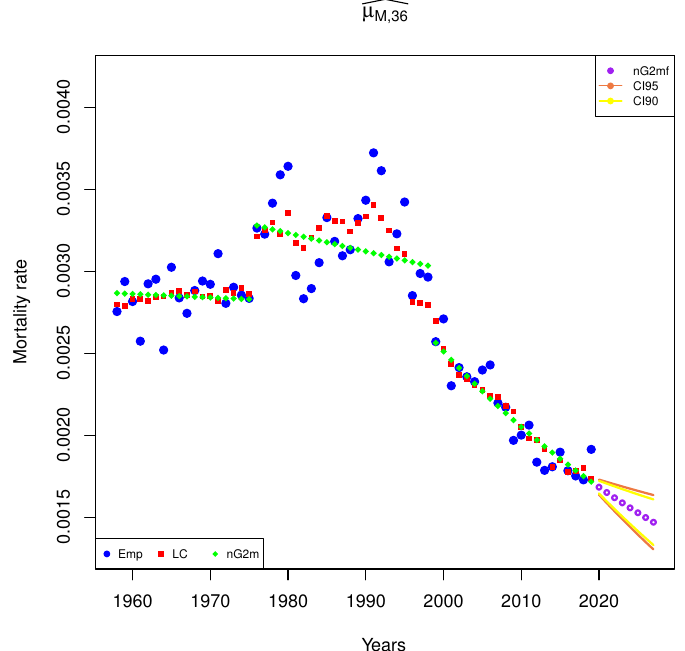
Figure 4. The values of mortality rates—male, age 36: empirical (Emp), theoretical (LC, nGs), forecasts (nGsf), and c. interval based on the LC, and nGs model with